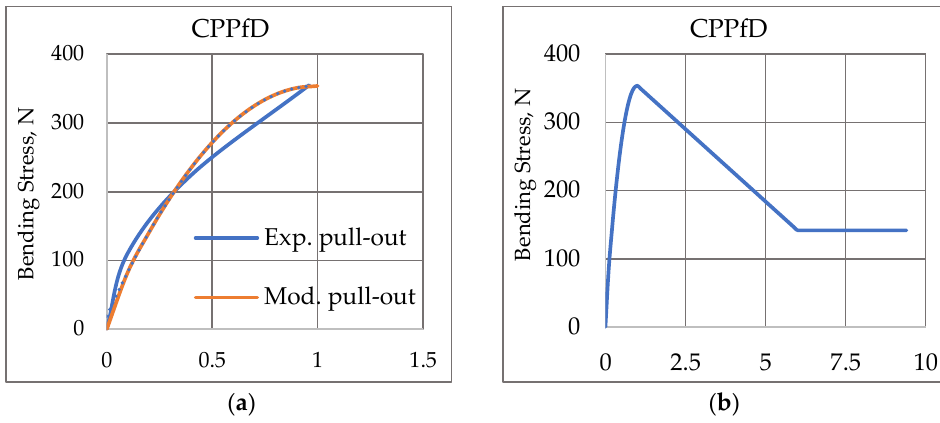
Figure 9. Back analysis. Pull-out curve for single Durus PP fiber: ( a ) pull-out curve at the stage till the first peak; ( b ) whole curve.